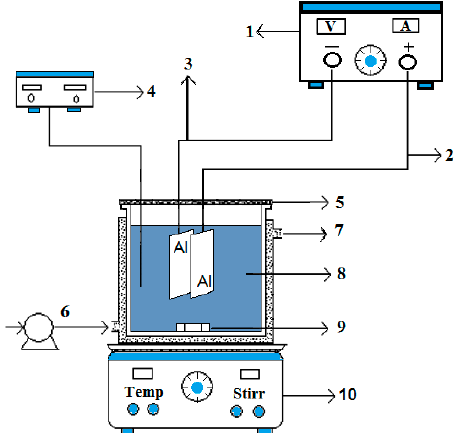
Figure 1. The electrolytic reactor. (1) DC power supply, (2) Anode, (3) Cathode, (4) pH meter, (5) PVC cover, (6) and (7) Inlet and outer jacket, (8) cold meat industry wastewater, (9) Magnetic stirrer bar and (10) Magnetic stirrer.